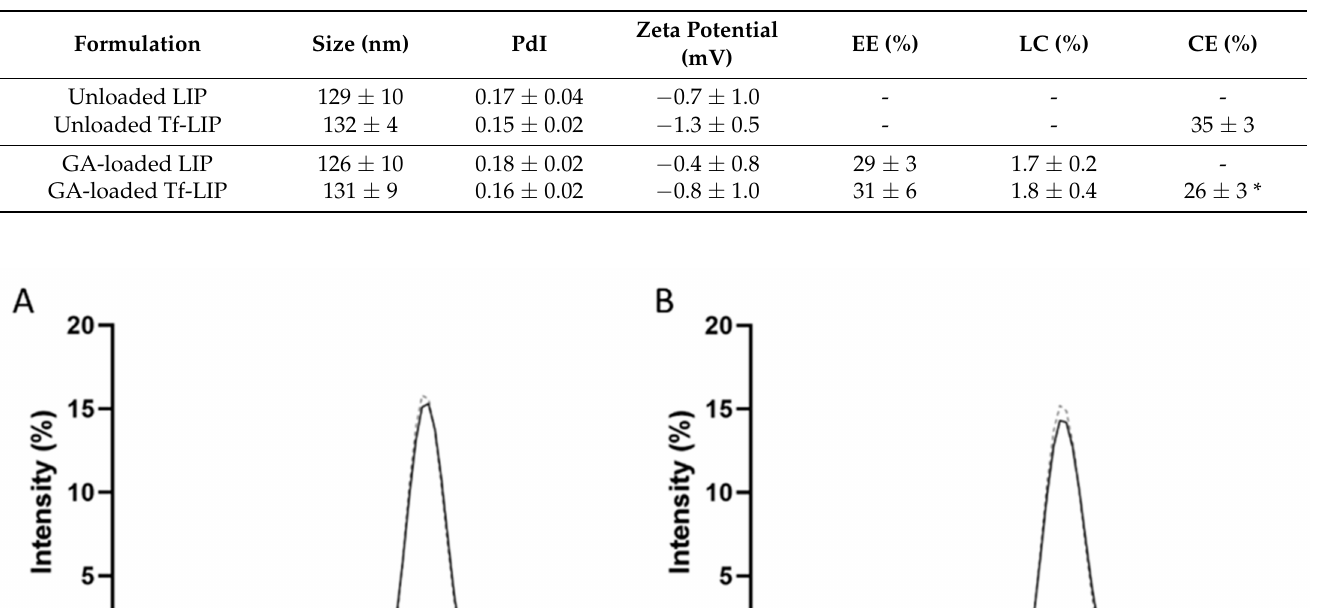
Table 2. Physicochemical properties of unloaded and GA-loaded liposomes, without and with Tf functionalization. * Implies a statistical difference between GA-loaded liposomes before and after Tf functionalization ( p < 0.05).